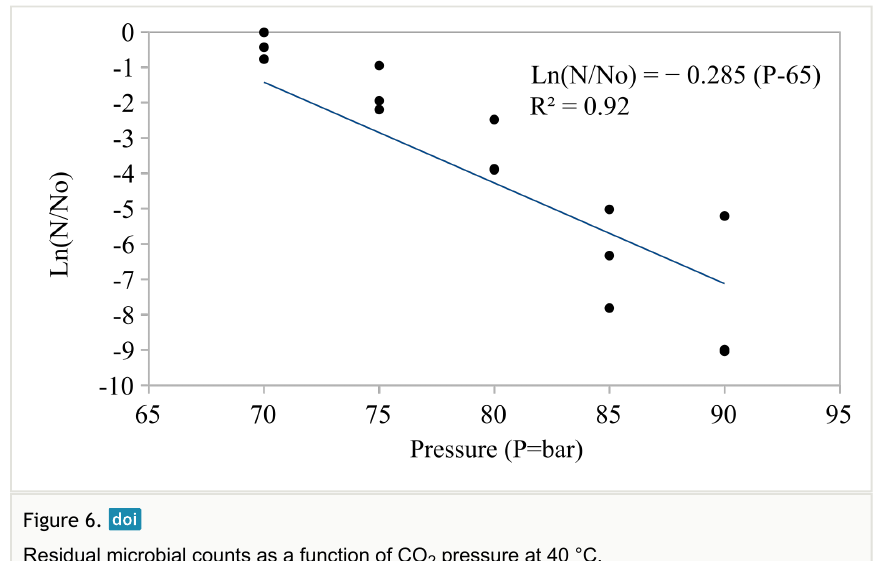
The relationship between CO pressure and CO density at 40 °C. 2 As shown in Fig. 6, 70 and 75 bar were found inadequate to make significant effect on reduction of microbial counts. After 90 bar exposure, the reduction of microbial loads was still less than 4-logs. The relationships between CO pressure and CO density with 2 residual microbial counts were found to follow first order reaction, as shown in Fig. 6 and Fig. 7, respectively.